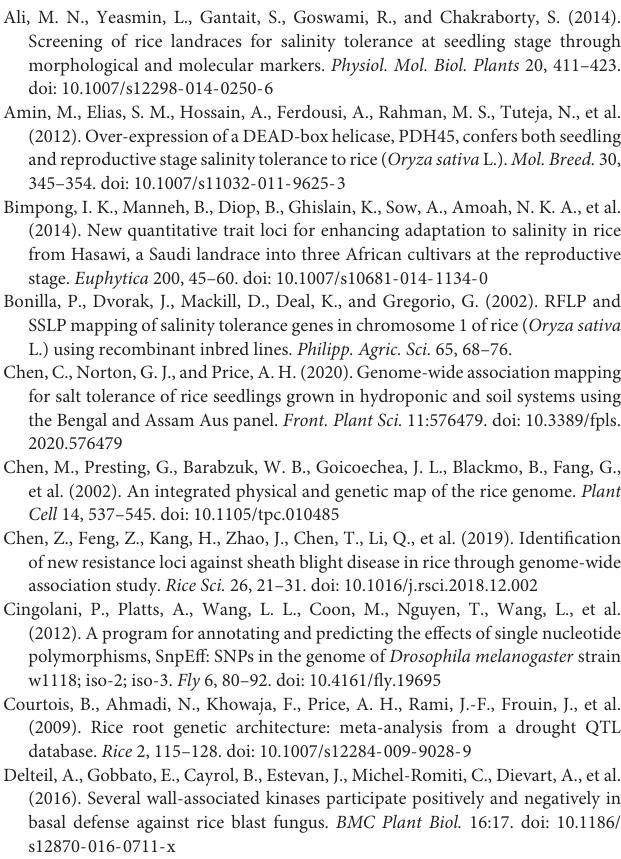
and third quartile. Plotlines extending from the boxes (whiskers) indicate variability outside the upper and lower quartiles. Each point represents a variety, and the black points represent outliers. Supplementary Figure 3 | Comparison of mean value of each ST index among 5 subgroups at seedling and reproductive stages. Error bars mean the standard errors. Different lowercase letters represent significant difference at the P value of 0.05, and “NS” means no significant difference (Kruskal-Wallis one-way ANOVA, Bonferroni correction). Aromatic subgroup was not included in this analysis because the samples are too less. Supplementary Figure 4 | Distribution of gene-based/tightly linked SNP markers in rice genome. Different colors represent the density of SNP markers within 1Mb window size on the chromosome. Supplementary Figure 5 | Correlation of the accessions accumulated the number of low frequency favorable haplotypes and the ST indices value at the seedling stage. The dotted line and gray region represent the linear regression and 95% CI, respectively. Supplementary Figure 6 | Correlation of the accessions accumulated the number of low frequency favorable haplotypes and the ST indices value at the reproductive stage.The dotted line and gray region represent the linear regression and 95% CI, respectively. Supplementary Figure 7 | Transcription levels of 7 genes in 15 accessions at 12 and 24 hours after salt treatment. Error bars mean the standard errors. ** indicate the difference reached statistically significant difference at the P value <